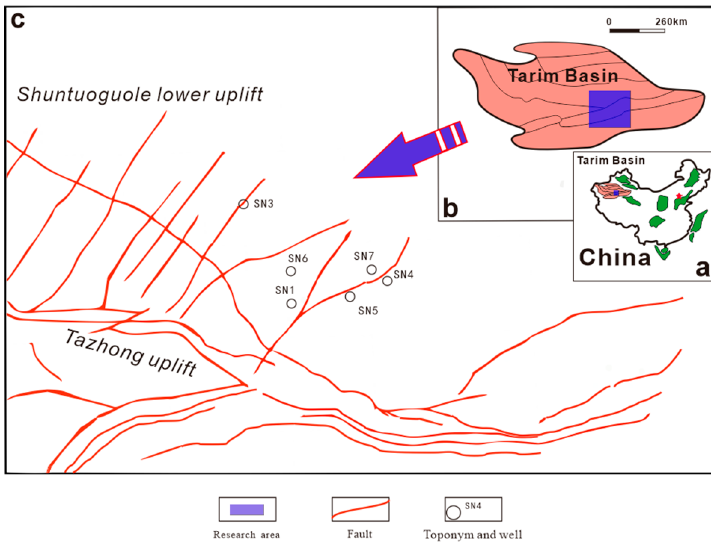
Figure 1. Tectonic locations of the Shunnan (SN) area in the northern slope of the middle Tarim Basin. a : Location of Tarim Basin in China; b : Location of SN in Tarim Basin; c : Tectonic map.